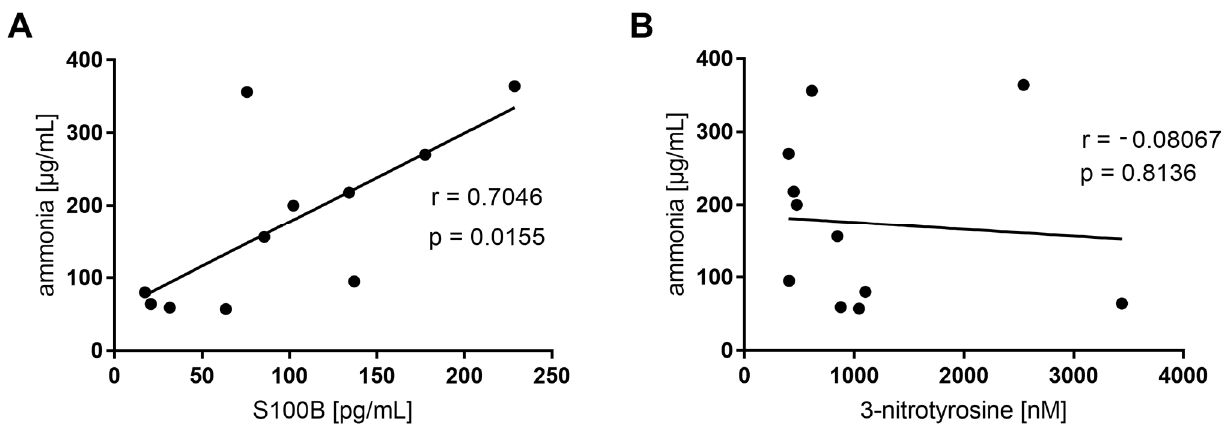
Figure 1. Pearson r correlation of ammonia and S100B ( A ) and 3-NT ( B ) among patients (n = 11).